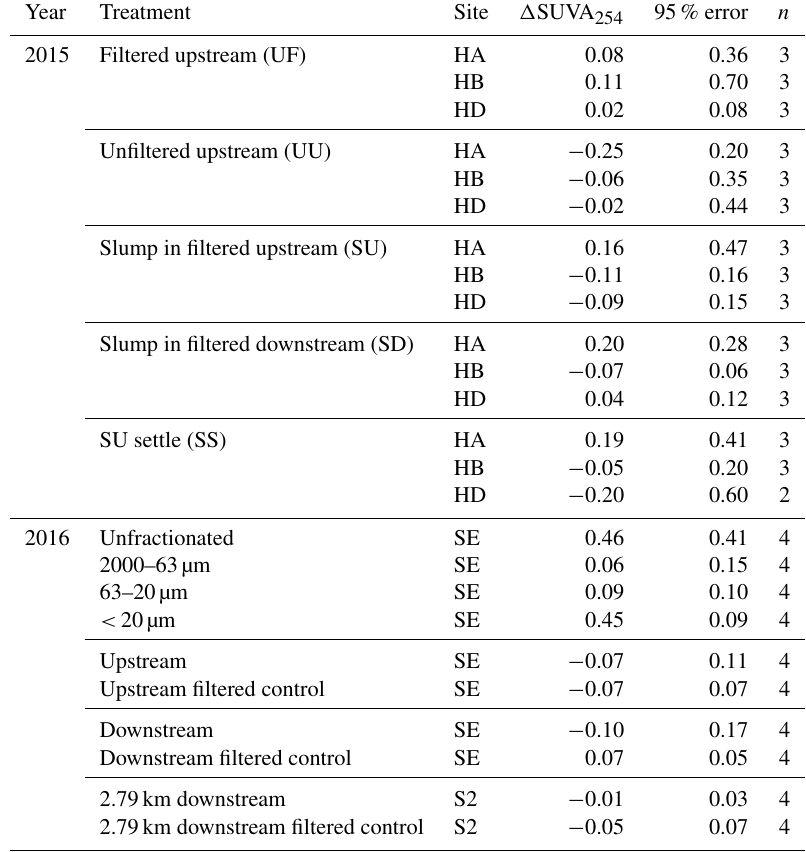
Table C1. Absolute changes in SUVA 254 in 2015–2016